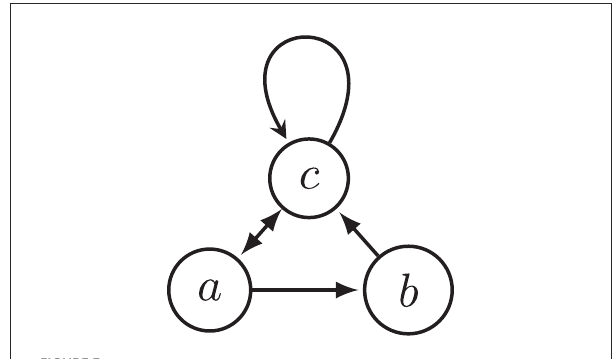
FIGURE3 Argumentation framework F 3 . It shows that CF2 semantics violates INRA since both extensions ( { a } and { b } ) attack c , but after removing c , { b } is no longer an extension.